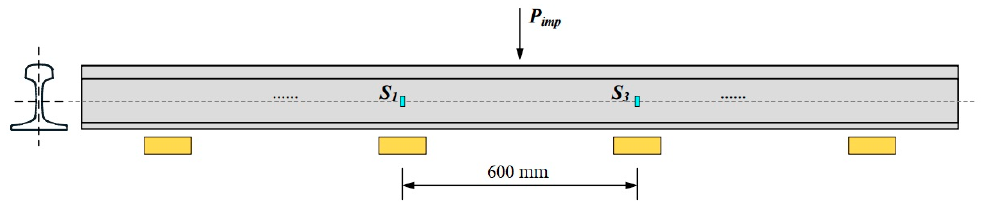
Figure 6. Plans for sensor arrangement [77].